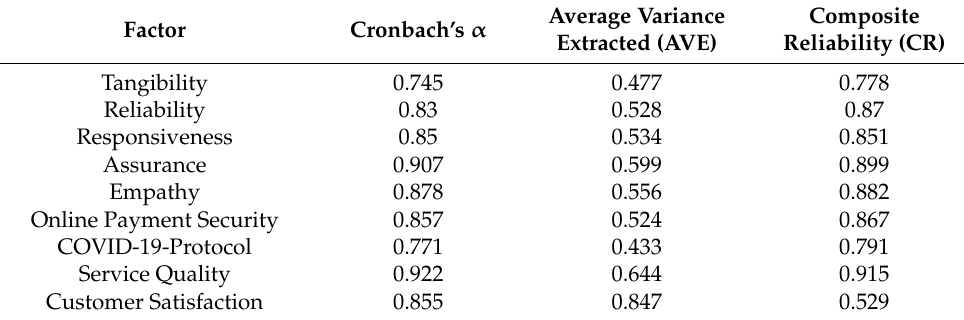
Table 4. Construct Validity Model.